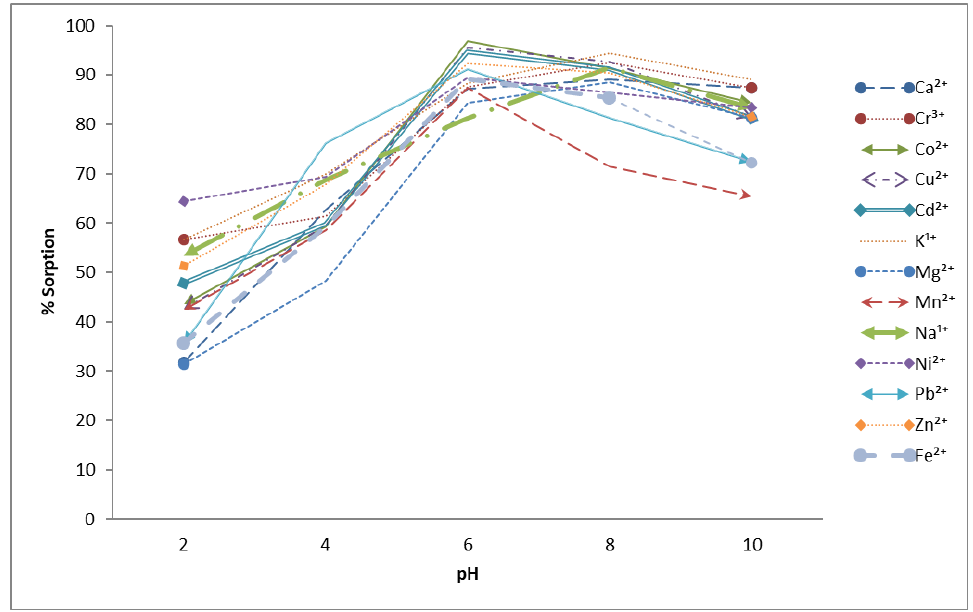
Figure 3. Effect of pH on % sorption of metal ions using Aerva javanica as the sorbent (60 ppm each metal concentration, 60 min contact time and 150 rpm shaking speed). metal concentration, 60 min contact time and 150 rpm shaking